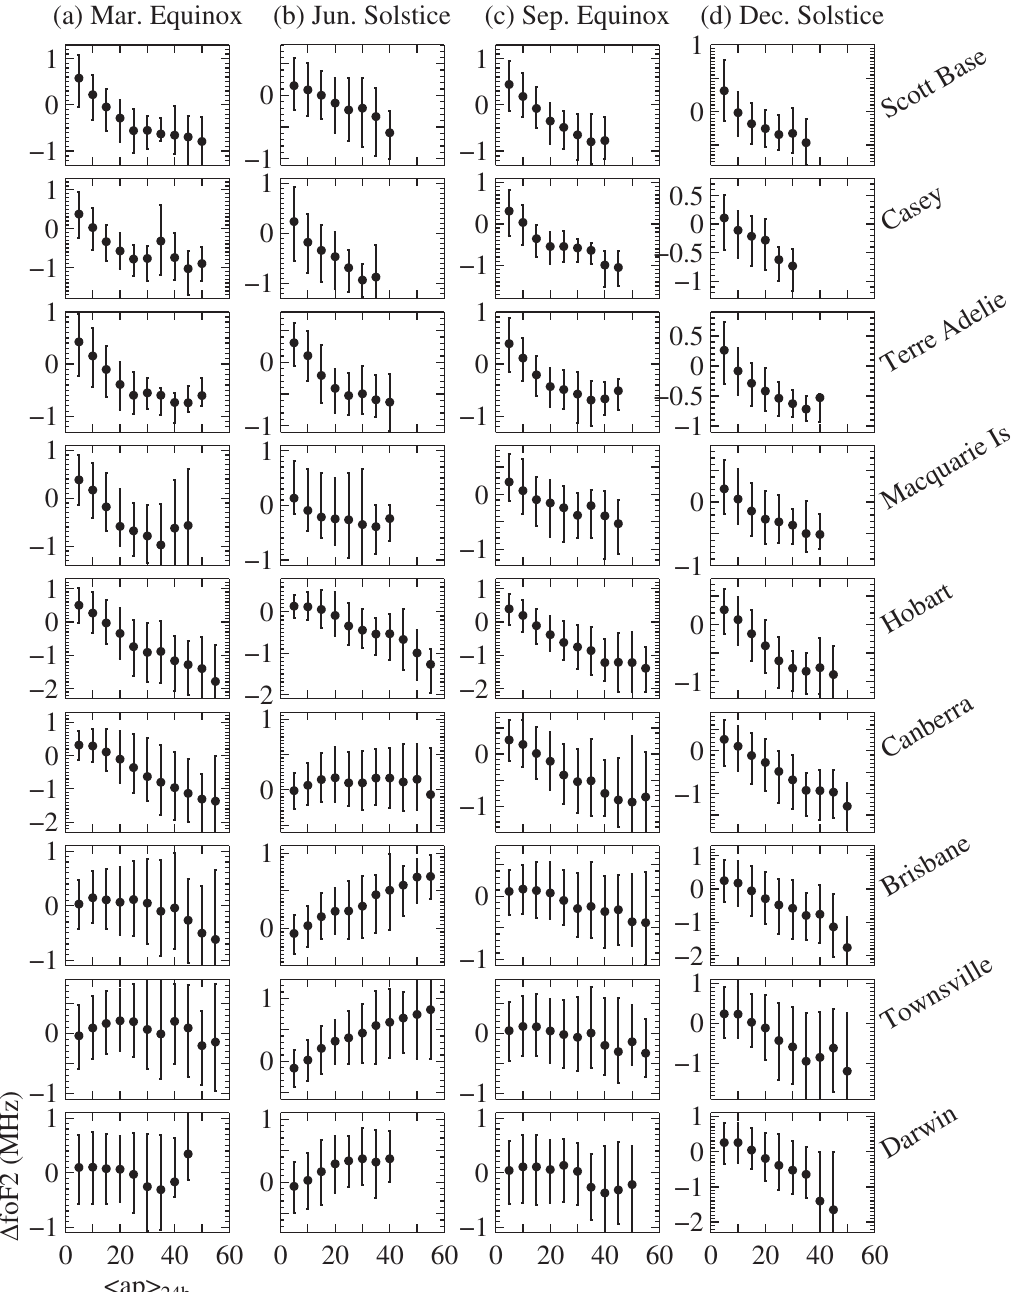
Fig. 5. Same as Figure 4 but for the southern hemisphere stations (from top to bottom: Scott Base, Casey, Terre Adelie, Macquarie Is, Hobart, Canberra, Brisbane, Townsville, and